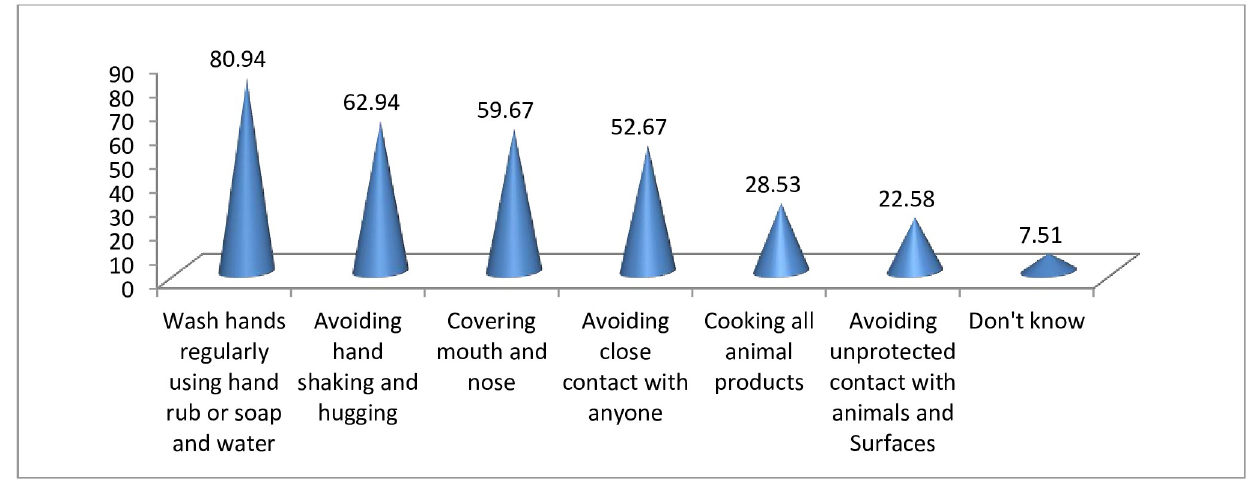
Fig 6. Percentage of information among respondents about COVID-19 preventive measures, Oromia region, Ethiopia, September 2020 to March 2021. NB: Percentage may not add 100% as multiple responses were possible.